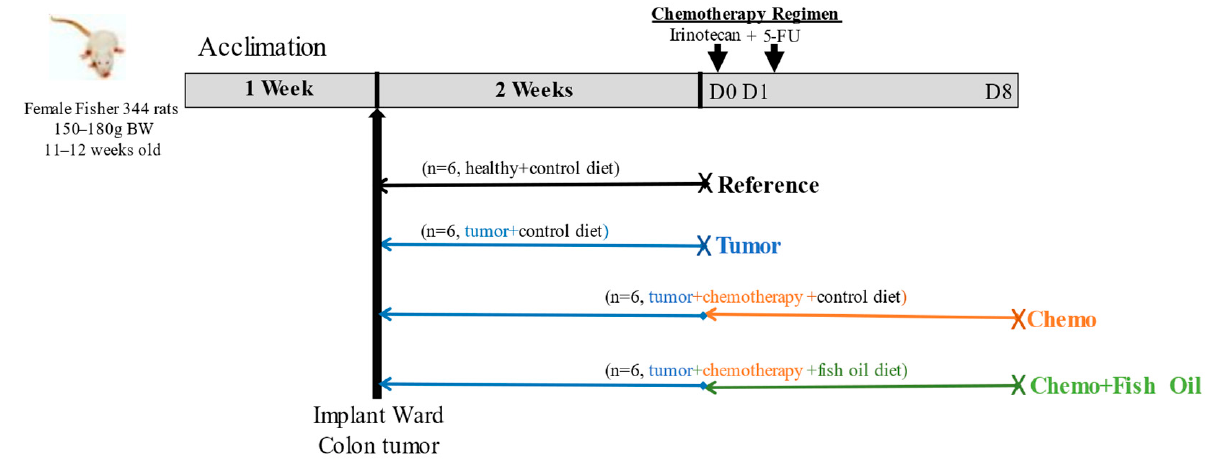
Figure 1. Study design. D, day; FU, fluorouracil; X, kill.